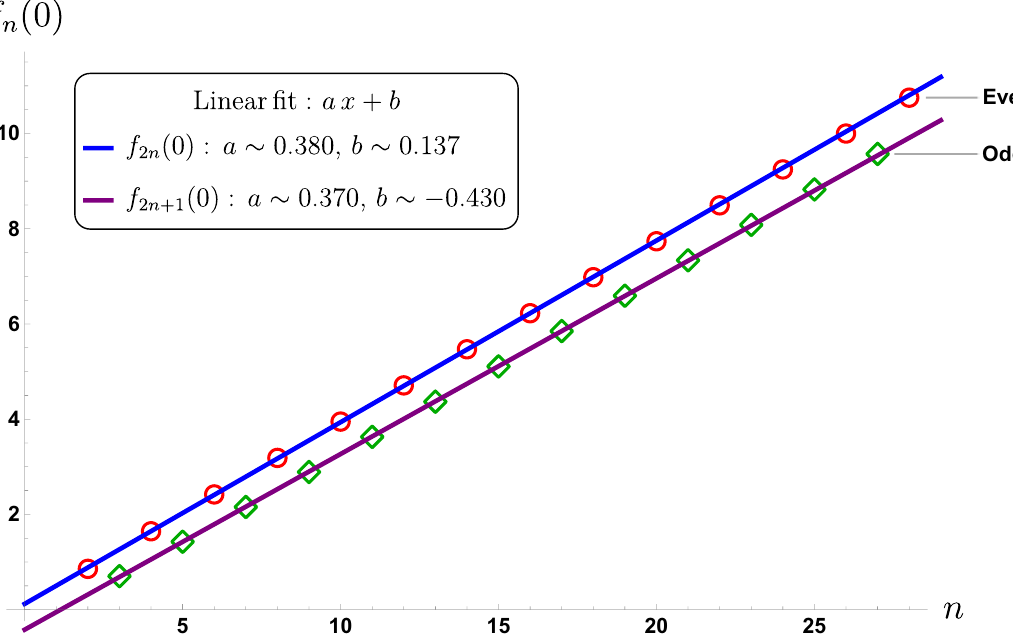
Figure 3 . Linear fits to f n (0) as a function of n . Done separately for even and odd n